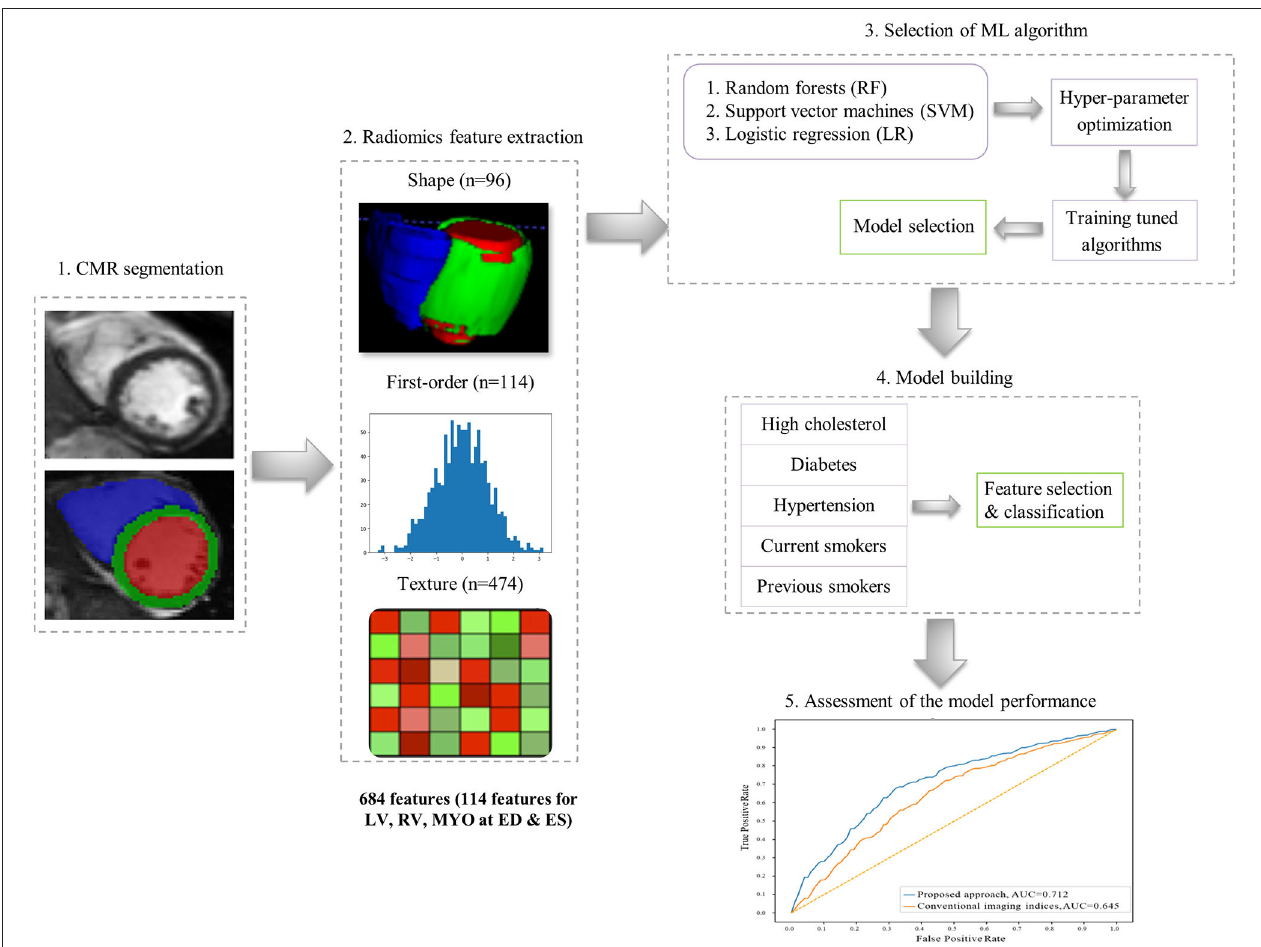
FIGURE 2 | The proposed radiomics